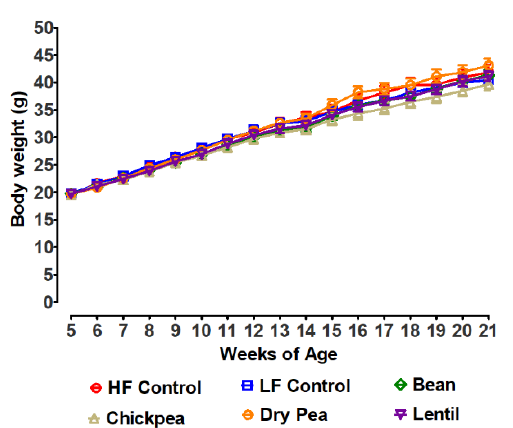
Figure 1. Effect of feeding pulse diets on body weight. HF Control n = 7, LF Control n = 7, Bean n = 6, Chickpea n = 7, Dry Pea n = 8, Lentil n = 8; HF: high fat; LF: low fat. Values are means ± SEM. Differences among groups at each timepoint were not statistically significant.